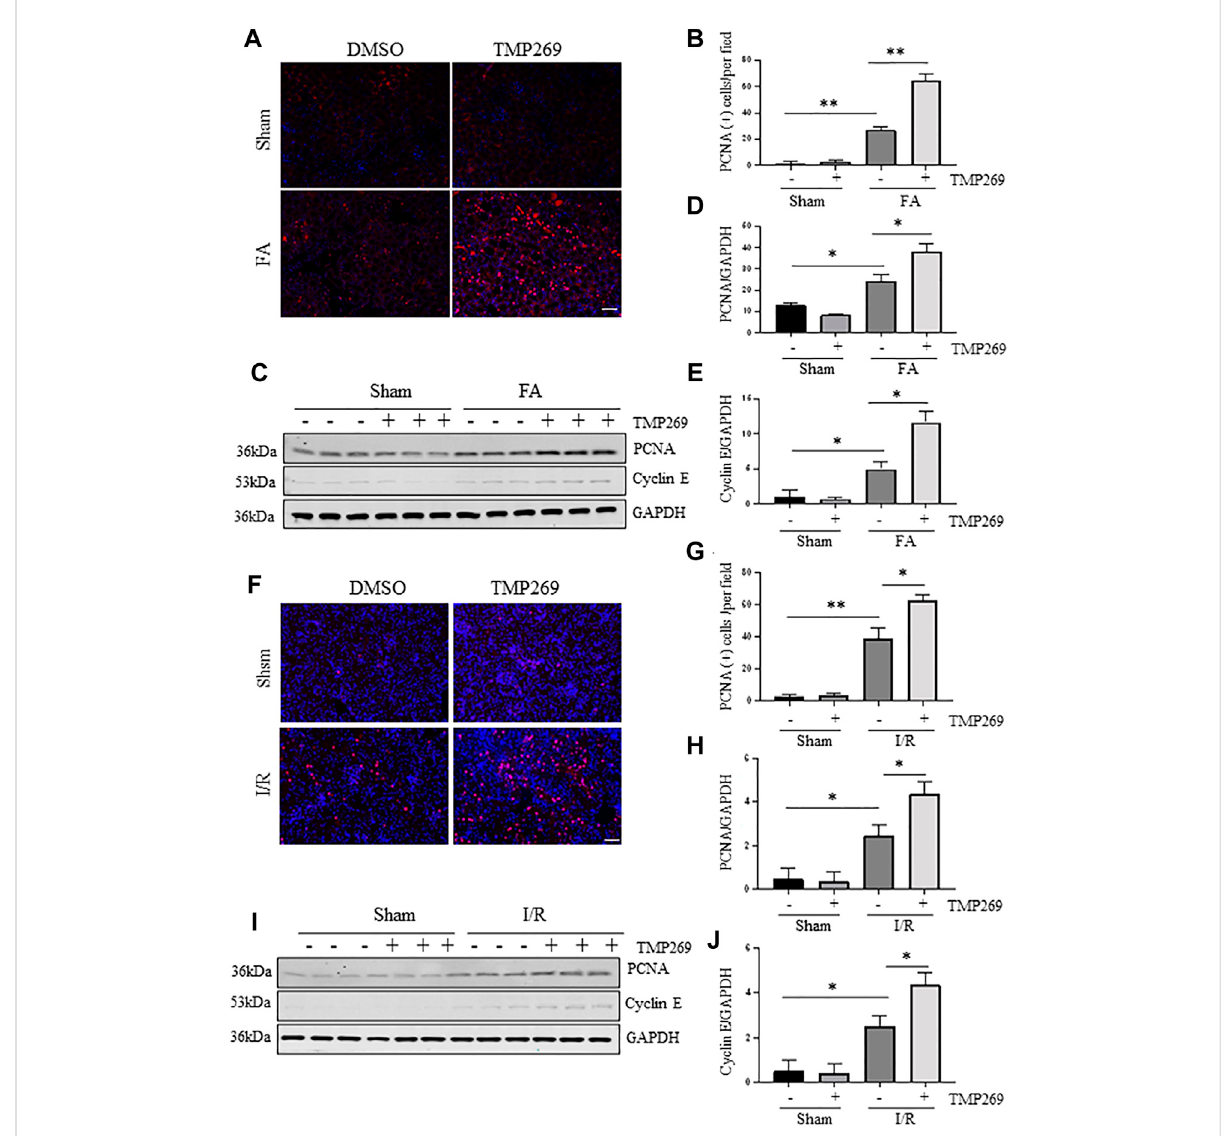
FIGURE 7 Administration of TMP269 promotes cell proliferation in the kidney following FA and I/R injury (A,F) Photomicrographs (×200) illustrate proliferating cell nuclear antigen (PCNA) immuno fl uorescent staining of the kidney tissues collected from murine models of FA or I/R-induced AKI. Scale bar, 20 µm. Original magni fi cation, ×200 (B,G) Tubular cells with positive PCNA staining were counted in 10 high-power fi elds and expressed as means ± SD (C,I) Kidney tissue lysates were subjected to immunoblot analysis with speci fi c antibodies against PCNA, Cyclin E or GAPDH. Representative immunoblots are three samples in each group. Expression levels of PCNA (D,H) and Cyclin E (E,J) were quanti fi ed by densitometry and normalized with GAPDH, respectively. Data are means ± SD ( n = 3). * < 0.05; ** p < 0.01; *** p <